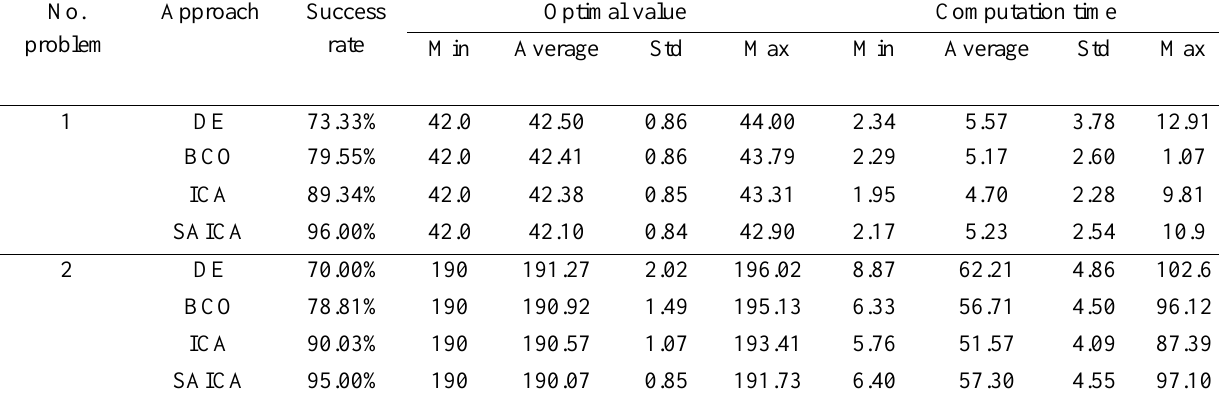
Table 8. The summary of results for two case studies after 30